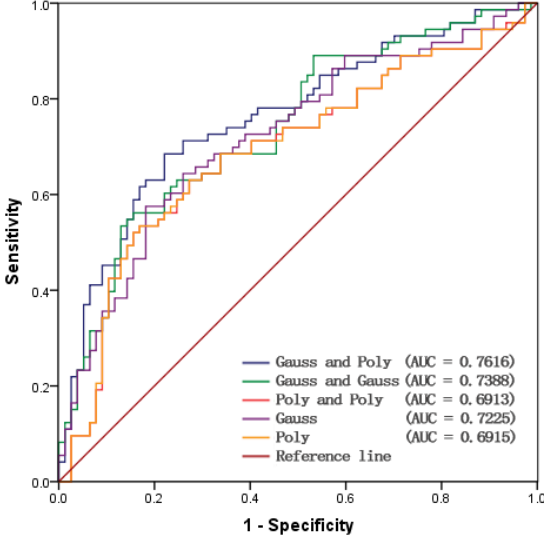
Figure 6. ROC curves for the different kernel type analyses.